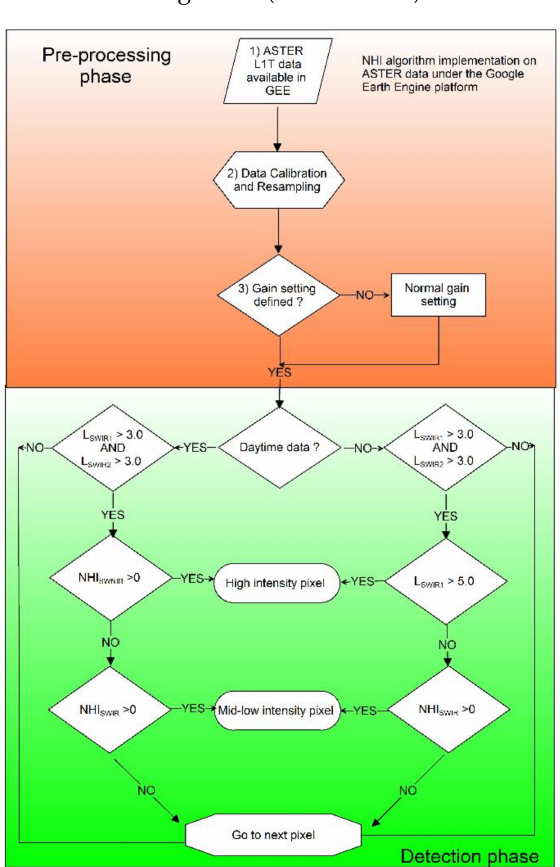
Figure 3. Flowchart of the Normalized Hot Spot Indices (NHI) detection scheme applied to ASTER data of 2000–2008 under Google Earth Engine